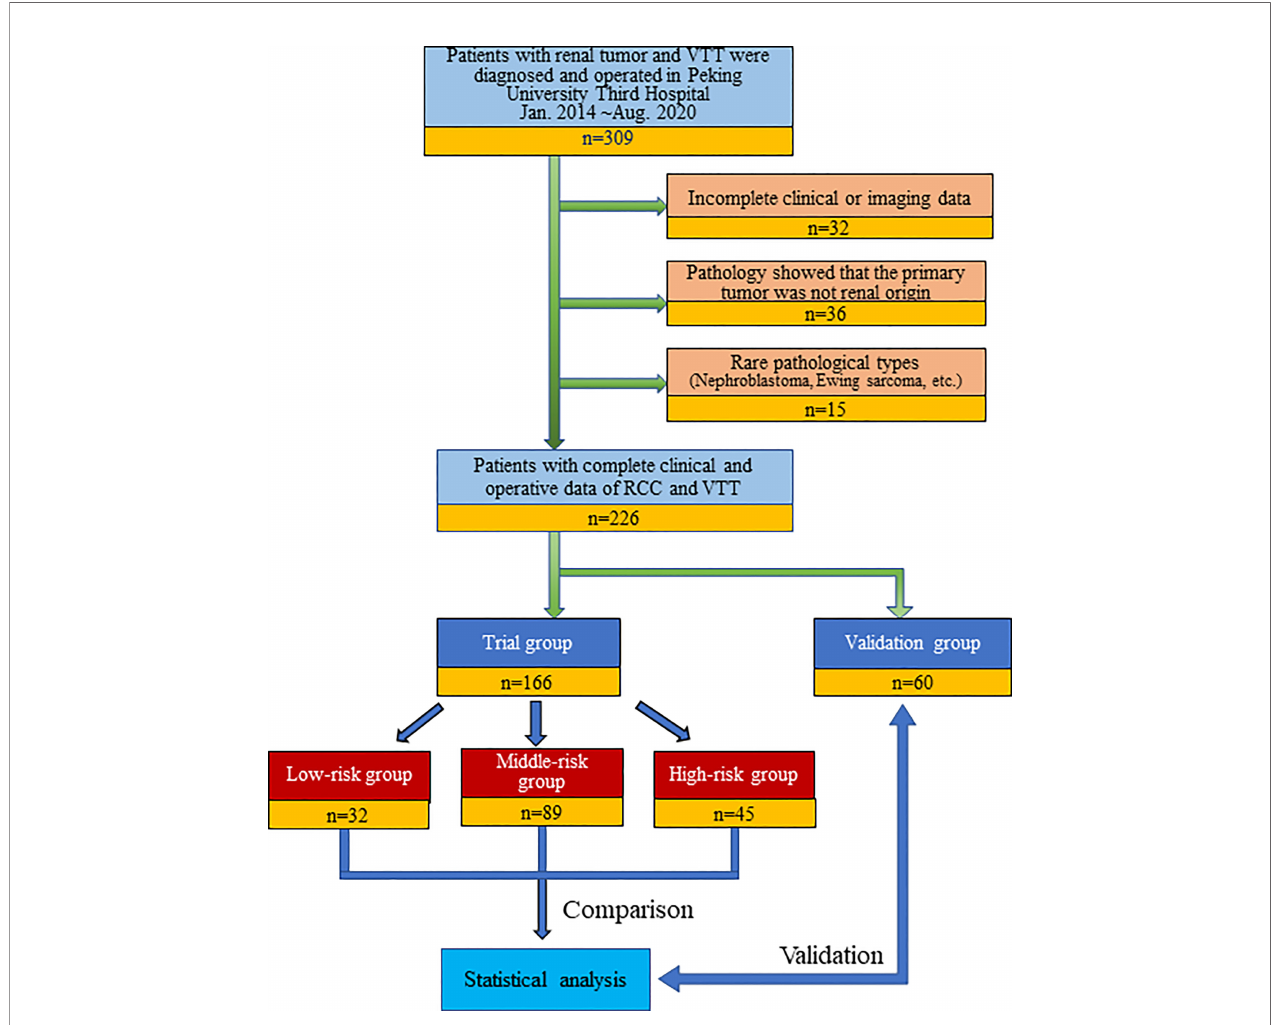
FIGURE 1 | Flow chart of study cohort selection and research strategy.